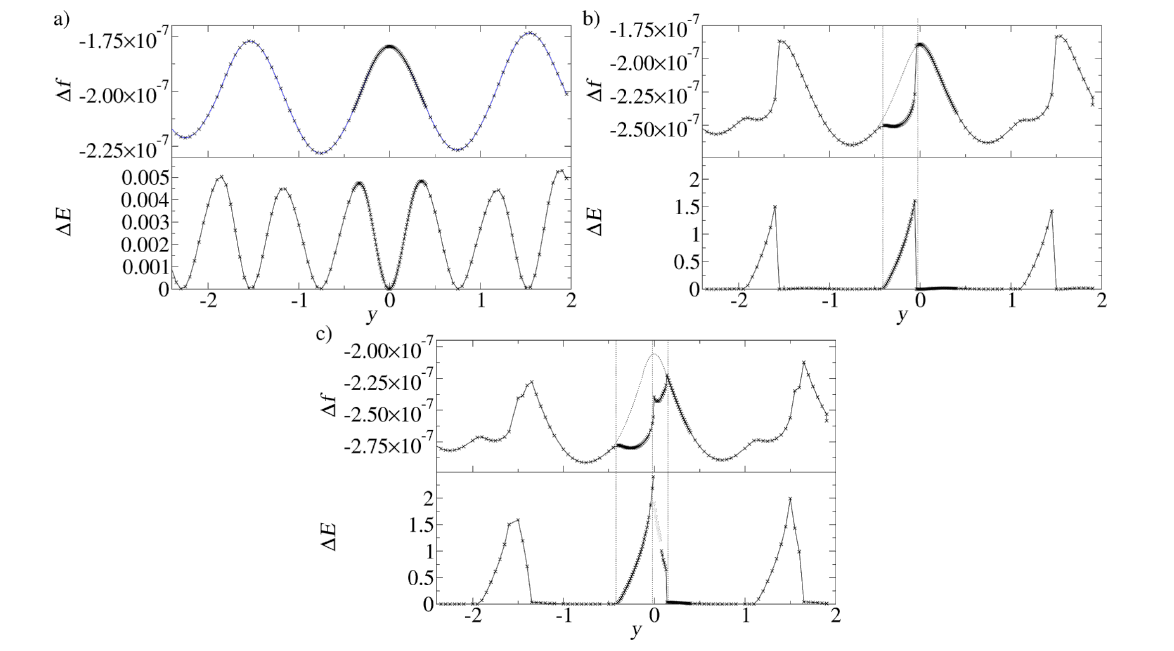
Figure 7: Simulated constant-height scans along the line shown in Figure 2 for a Lennard-Jones system (position A at y = 0). The nominal distances are a) d = 1.30, b) d = 1.22, c) d = 1.12. Frequency shift and damping of the cantilever are shown. For b) and c) adhesion hysteresis occurs near posi- tion A. The dissipation signal is correlated with a frequency drop. For c) there is an interval to the right of position A, where the atomic configuration of the tip changes irreversibly (grey), i.e., Δ E is the energy dissipated in the first cycle